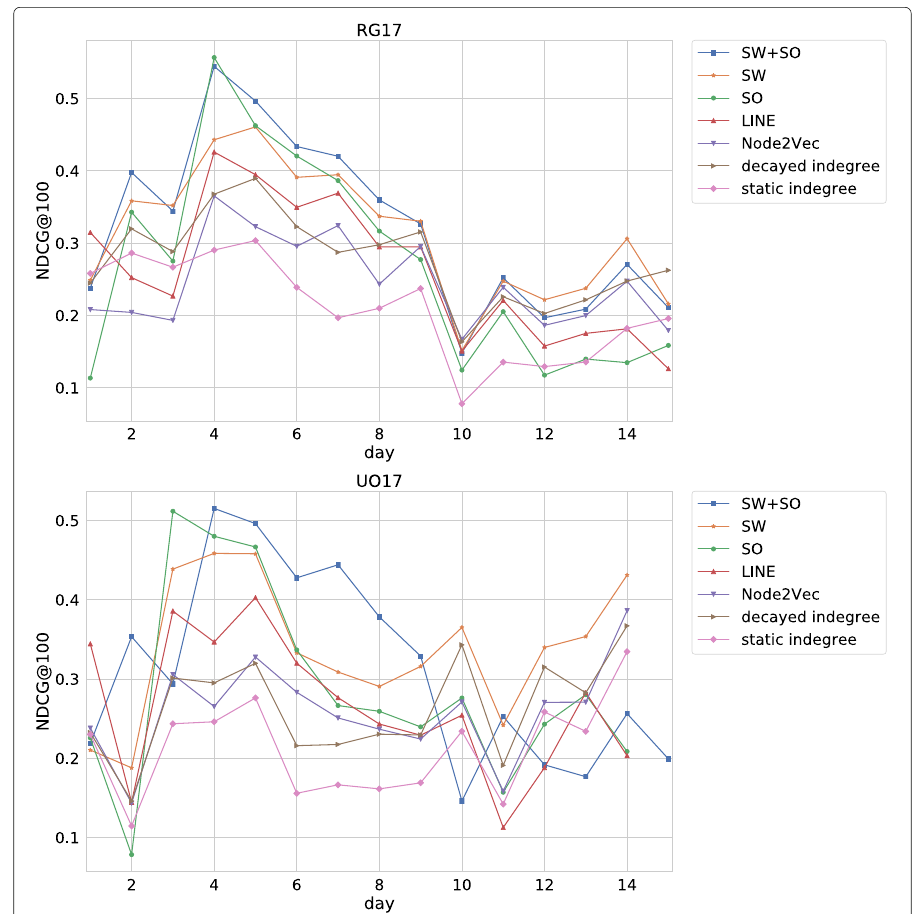
Fig. 13 Best model performance over time for RG17 ( top ) and UO17 ( bottom ) tennis data sets. For each day the average NDCG@100 over the four daily snapshots is